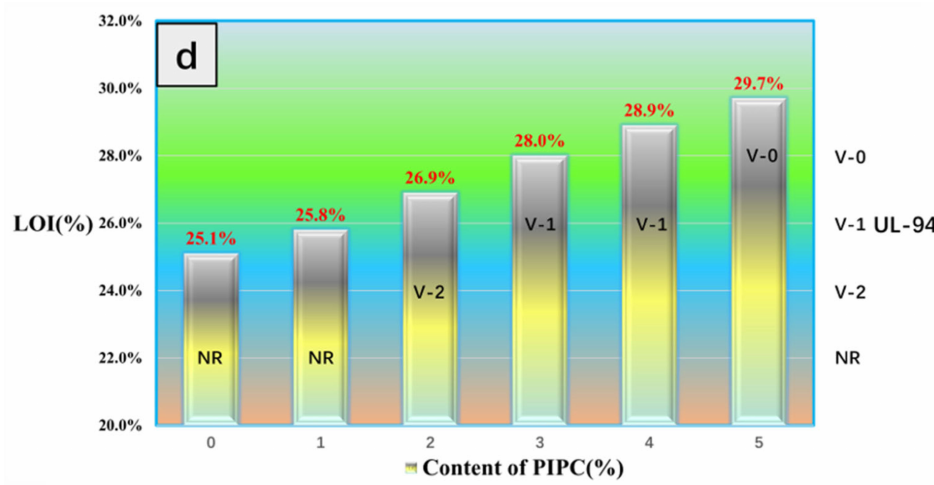
Figure 5. ( a ) TGA curves; ( b ) DTA curves; ( c ) DSC curves; ( d ) limiting oxygen index (LOI) and vertical burning tests of EP control and EP / PIPC composites. Table 2. The thermal analysis data for EP control and EP / PIPC composites. Samples T 5% ( ◦ C) T max ( ◦ C) Residues at 600 ◦ C Residues at 800 ◦